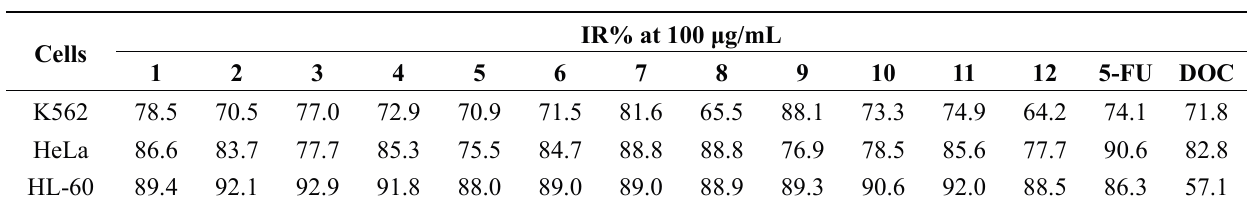
IR% at 100 μ g/mL